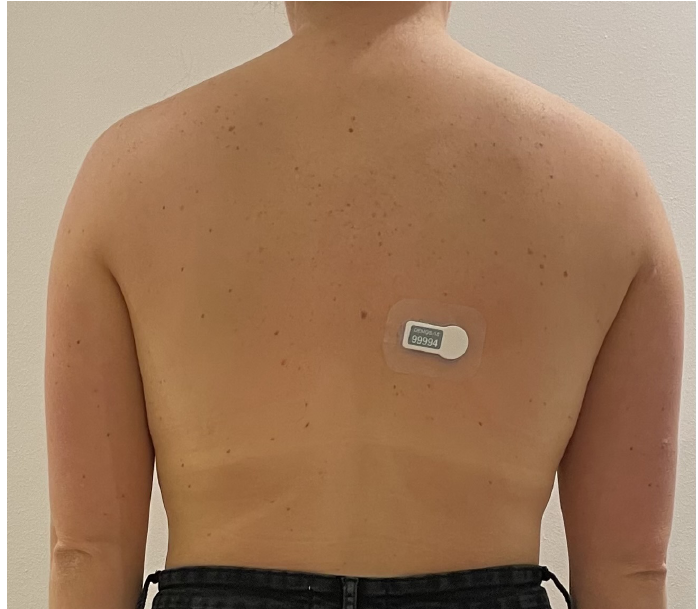
Figure 1. An example of sensor placement on the back of the